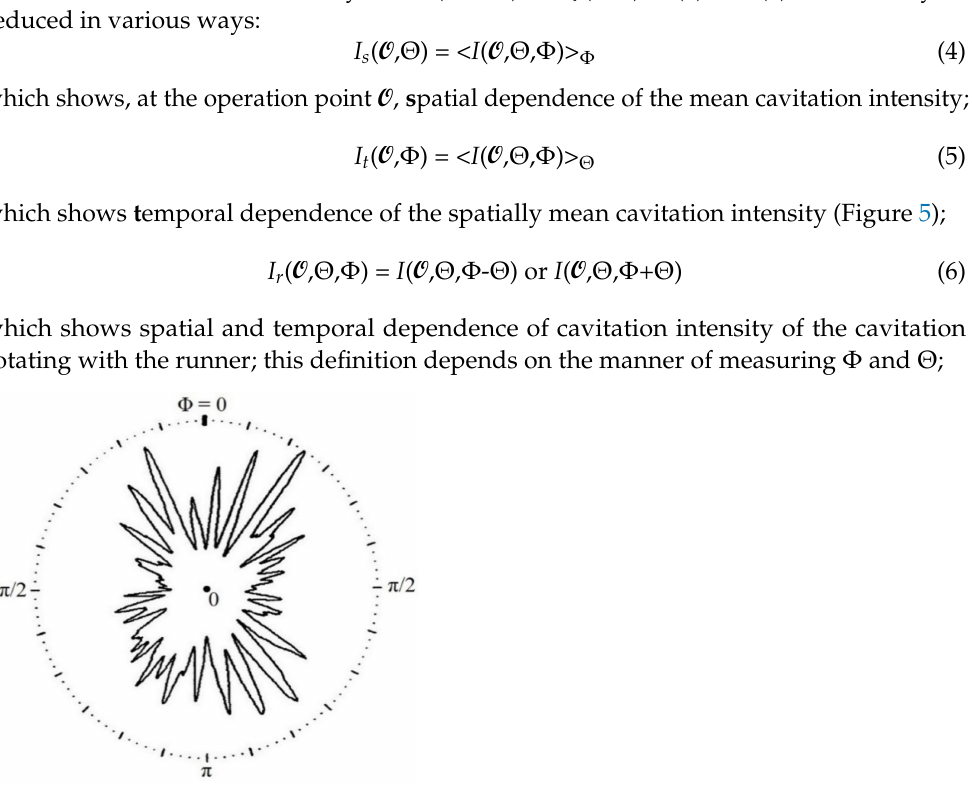
Figure 3. Front panel of the multidimensional data acquisition processor. The simplest description